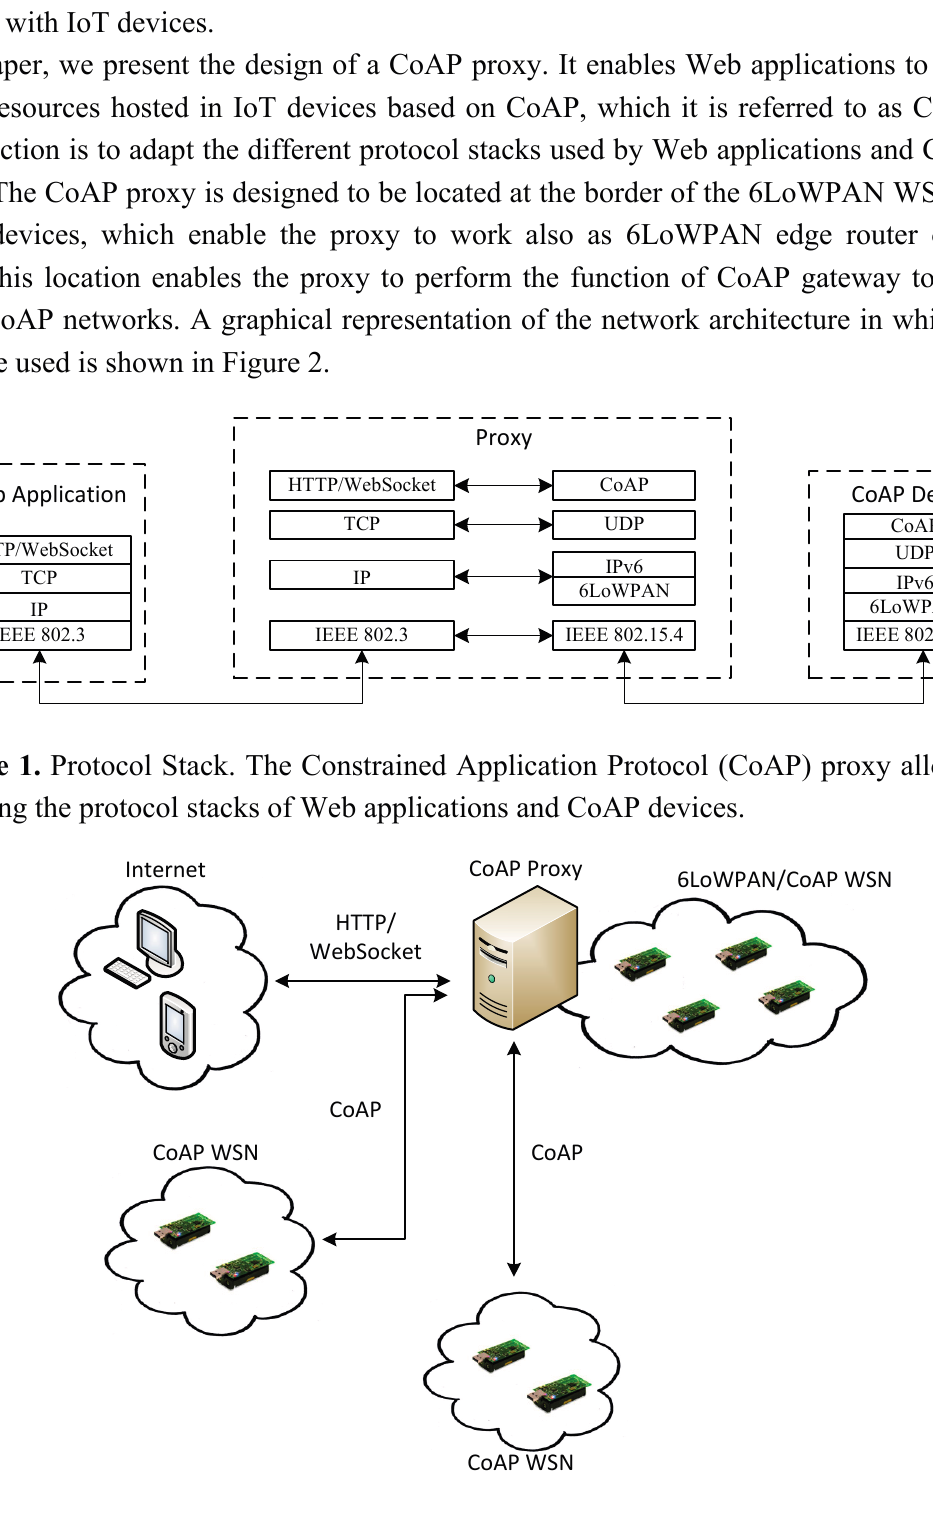
Figure 2. Network architecture. The CoAP proxy also has the IPv6 over Low power Wireless Personal Area Networks (6LoWPAN) edge router and gateway functions to interconnect disjointed CoAP